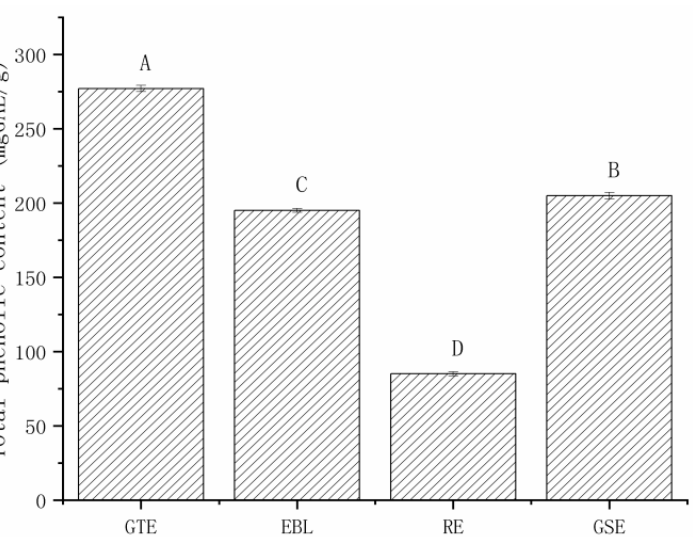
Figure 1. The total phenolic contents of four extracts. Note: GTE: pickling solution with green tea extract; EBL: pickling solution with extract of bamboo leaves; GSE: pickling solution with grape seed extract; RE: pickling solution with rosemary extract. Different letters (A, B, C and D) indicate significant differences ( p <